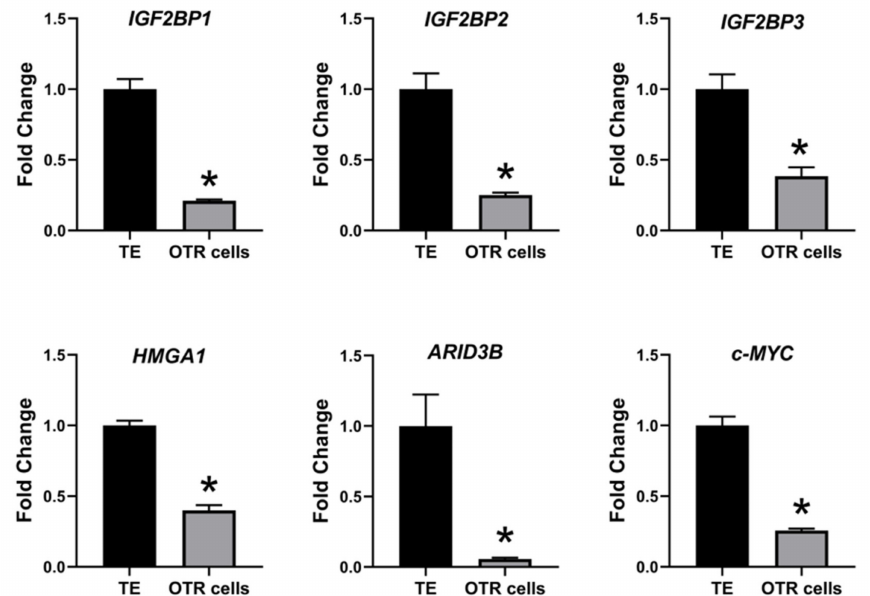
Figure 6. IGF2BP1, IGF2BP2, IGF2BP3, HMGA1, ARID3B, and c-MYC mRNA in OTR cells compared to day 16 TE ( n = 3), * p < 0.05 vs. TE.